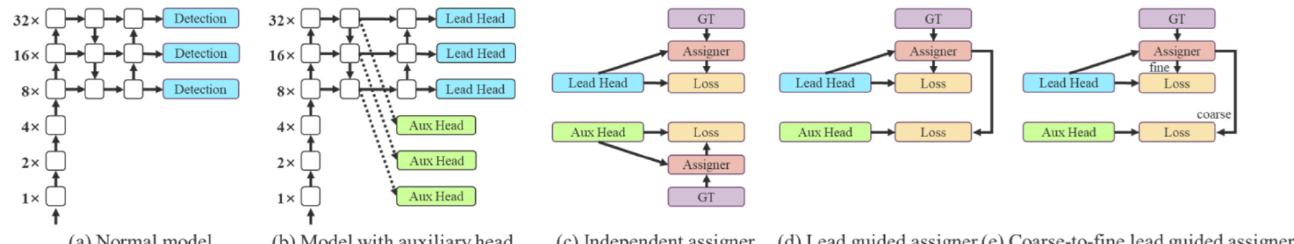
Figure 14. Illustration of coarse for auxiliary and fine for lead head label assigner